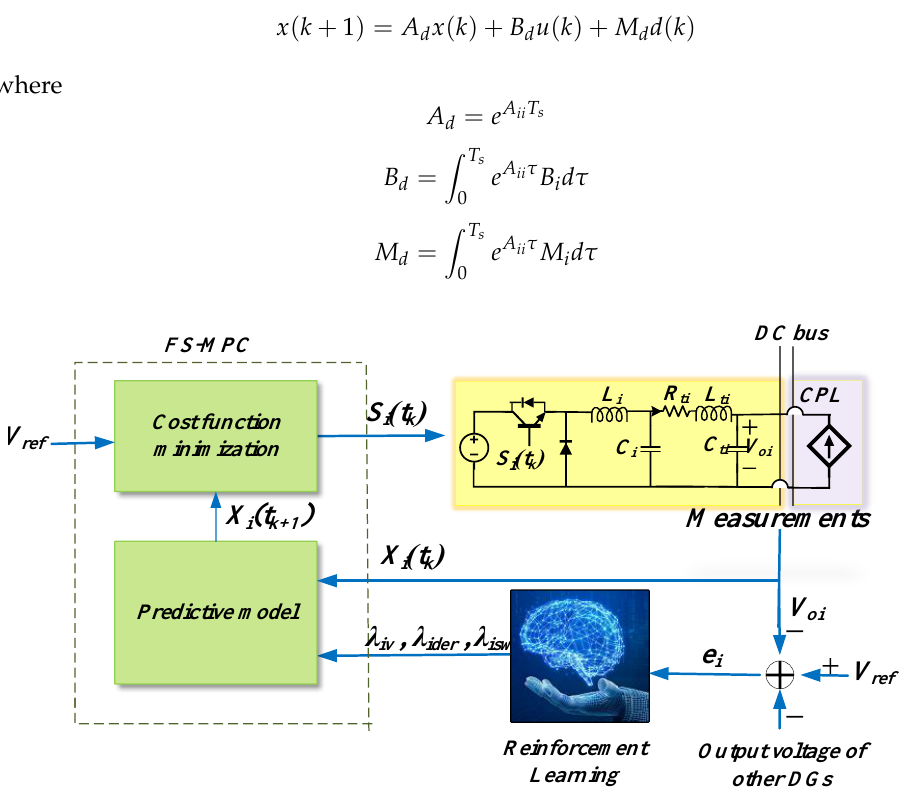
Figure 2. Proposed control scheme for a dc-dc buck